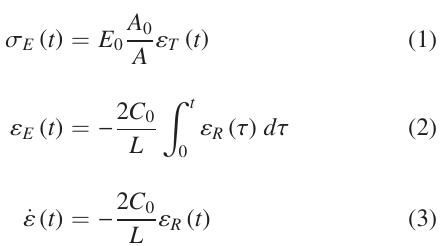
Fig. 6. Engineering stress versus strain at di ff erent strain-rates for AA